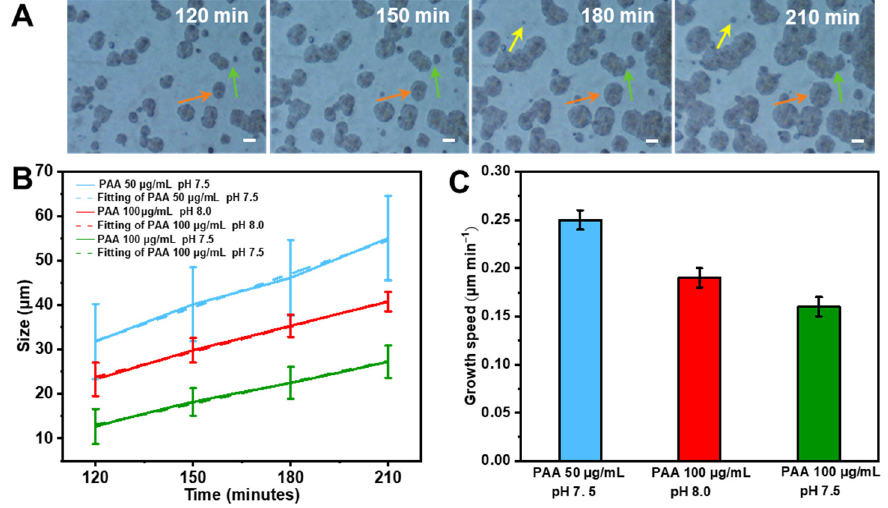
Figure 6. The growth process of HAP nanocrystals in collagen fi lms. ( A ) In situ monitoring of the growth process of HAP nanocrystals in collagen fi lms in the growth solution (PAA 50 µg/mL pH 7.5). Images were taken at 120 min, 150 min, 180 min, and 210 min, respectively, from left to right (scale bar, 20 µm). ( B ) Size of areas over reaction time in di ff erent conditions of growth solution. ( C ) The growth speed of areas in di ff erent conditions of growth solution.